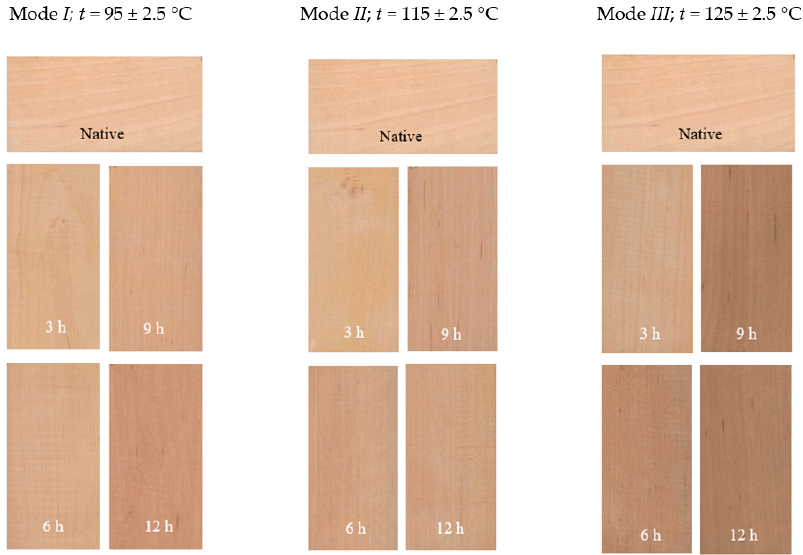
Figure 3. Changes in the color of alder wood during thermal modification. Visual inspection of the thermally treated alder wood on the loading surfaces and in the middle of the side surfaces of the sawn blanks, as well as color measurements with the Color Reader CR-10 colorimeter on these surfaces showed that the wood is evenly colored throughout the cross section after 3 h thermal treatment of mode I ( t I = 95 ± 2.5 °C). The full-volume coloring of alder wood is realized thanks to the rapid heating of the wood in a pressure autoclave to the required technological temperature with saturated steam over the entire volume of the autoclave, as well as over the entire cross section of the material [16,37]. Rapid heating of the material creates suitable conditions for the processes of ex- traction of water-soluble substances, hydrolysis of polysaccharides, as well as changes in the structure of lignin of alder wood causing modification of the chromophoric system. The measured values of the color of the alder wood during the thermal treatment on the luminance coordinate L* and the color coordinates: a* —the coordinate of the red color, b* —the coordinate of the yellow color as well as the total color difference Δ E* are given in Table 6. Table 6. Measured color values on the coordinates L*, a*, b* in the CIE color space L* a* b*, as well as the values of the total color difference ∆ E * of alder wood during the process of thermal modification of wood color. Thermal Treatment Temperature